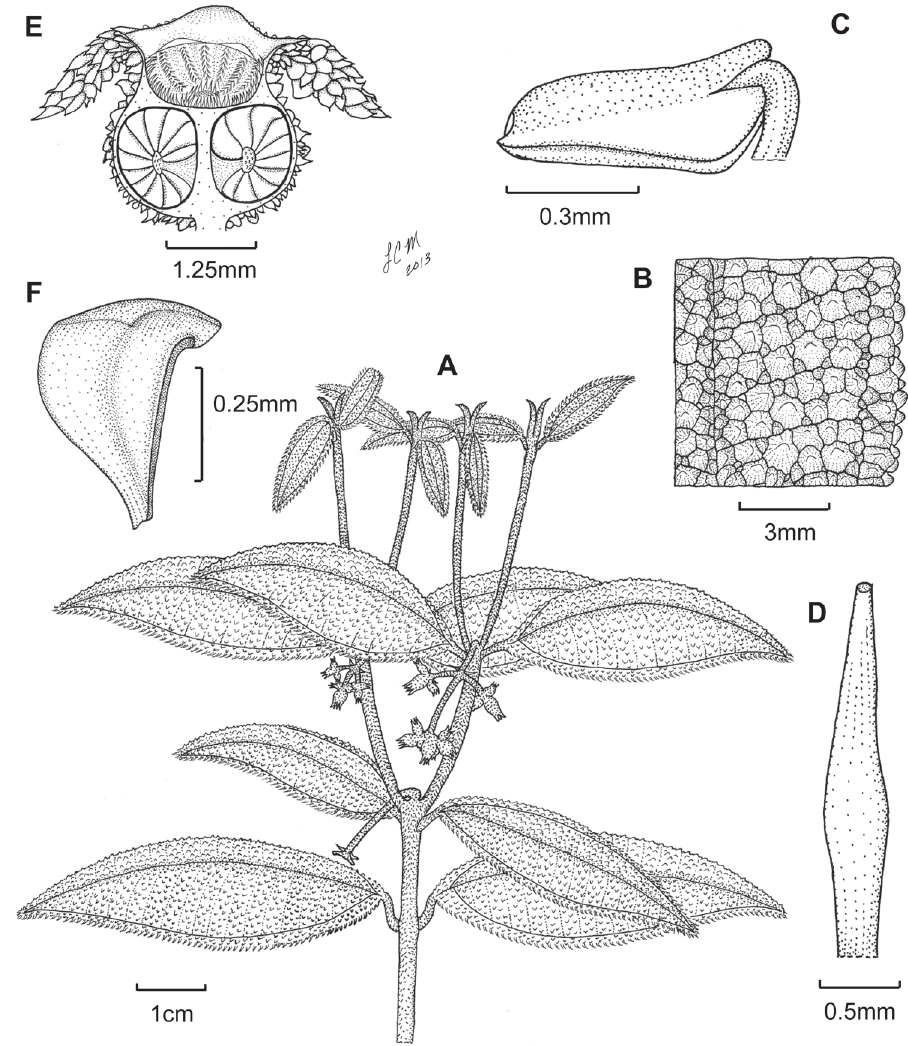
Figure 1. Illustration of Miconia bullotricha . A habit B close-up of leaf adaxial surface C immature stamen D style e fruit longitudinal section F seed (all from Bisse et al. HFC-49930